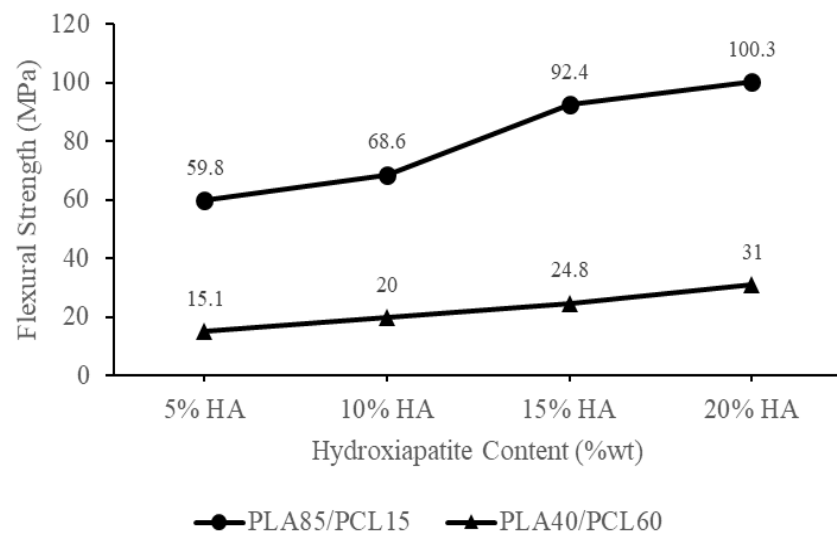
Figure 5. Flexural strength of the PLA/PCL/HA biocomposites.